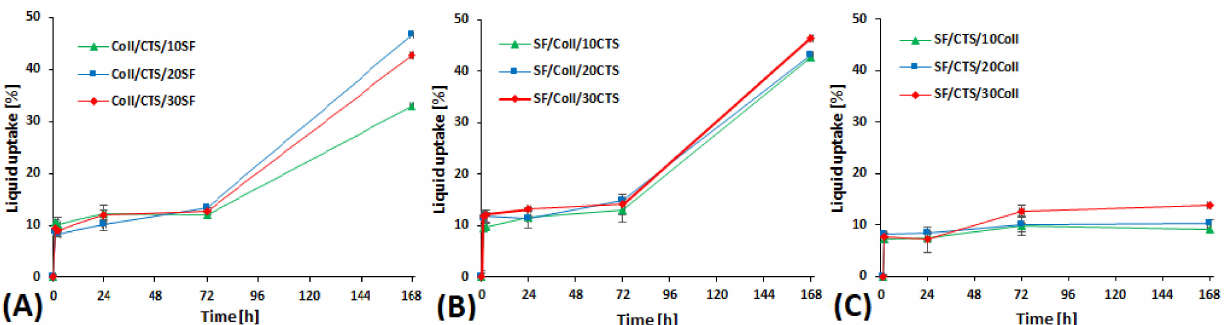
Figure 6. Result of liquid uptake in the studied scaffolds, cross-linked by EDC/NHS: ( A ) Coll/CTS mixture with 10, 20 and 30% of SF; ( B ) SF/Coll mixture with 10, 20 and 30% of CTS; ( C ) SF/CTS with 10, 20 and 30% of